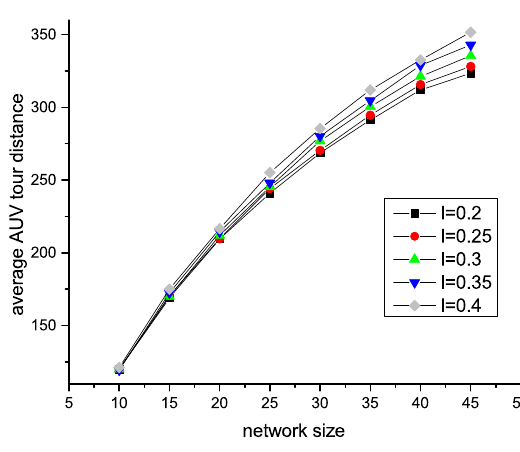
Figure 9. Effect of parameter l in centralized HAS 4 on tour.